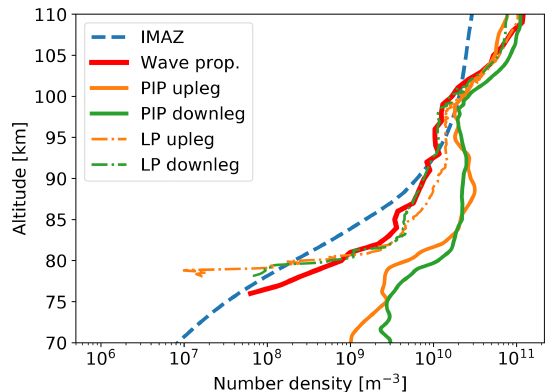
Figure 8. Positive ion (solid orange and green lines) and electron (dash-dotted orange and green profiles) densities measured by the PIP and LP instruments, respectively. The bold solid red line shows results of the wave propagation experiment. The blue dashed line shows electron density from the empirical ionospheric model for the auroral zone, IMAZ, derived for the time of the WADIS-2 flight (see text for details).